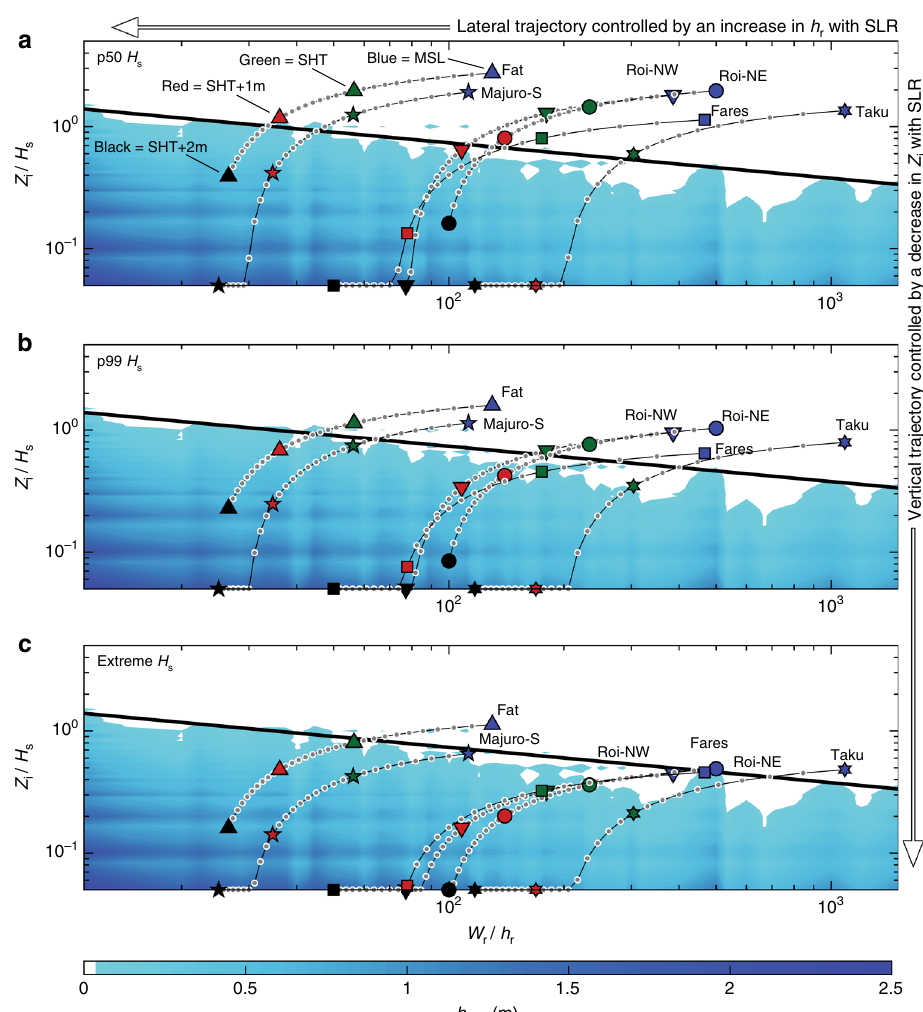
Fig. 3 Inundation trajectories for different atoll islands and wave conditions. Inundation trajectories range from present mean sea-level (blue markers) to spring high tide (SHT; green marker), SLR = 1m (red markers) and SLR = 2m (black markers). a Fifty percentile wave height speci fi c to each island (p50), b 99 percentile wave height (p90) and c extreme incident waves (average of the top 10 wave heights over 30 years). Trajectory curves account for how SLR will modify both axis because island elevation decreases ( y -axis) when reef depth increase ( x -axis), assuming no morphological adaptation. Overwash magnitudes (colour bar) for each combination of RRW and RIE, with associated standard error are the same in each plot and are presented in Supplementary Data